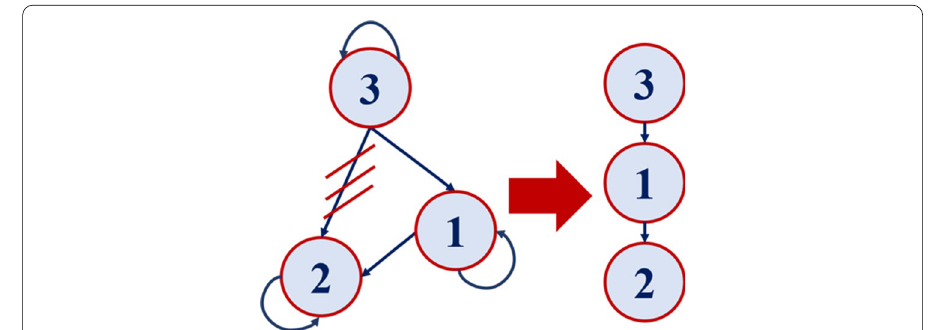
Fig. 3 Left: Initial tree diagram of microskills. Right: Final tree diagram of